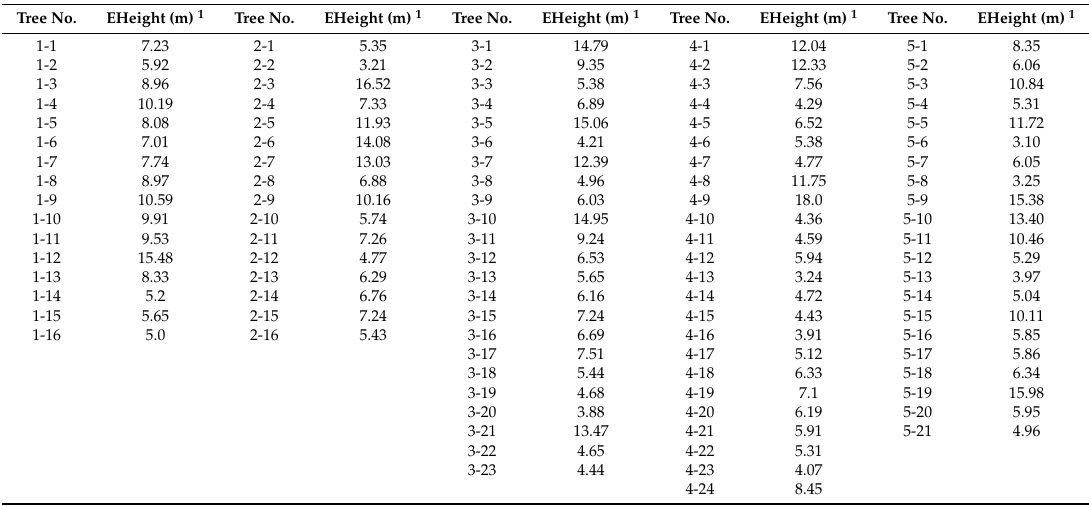
Table 2. The extracted heights of individual Minjiang fir trees in plots 1–5 from the CHM data. Tree No.